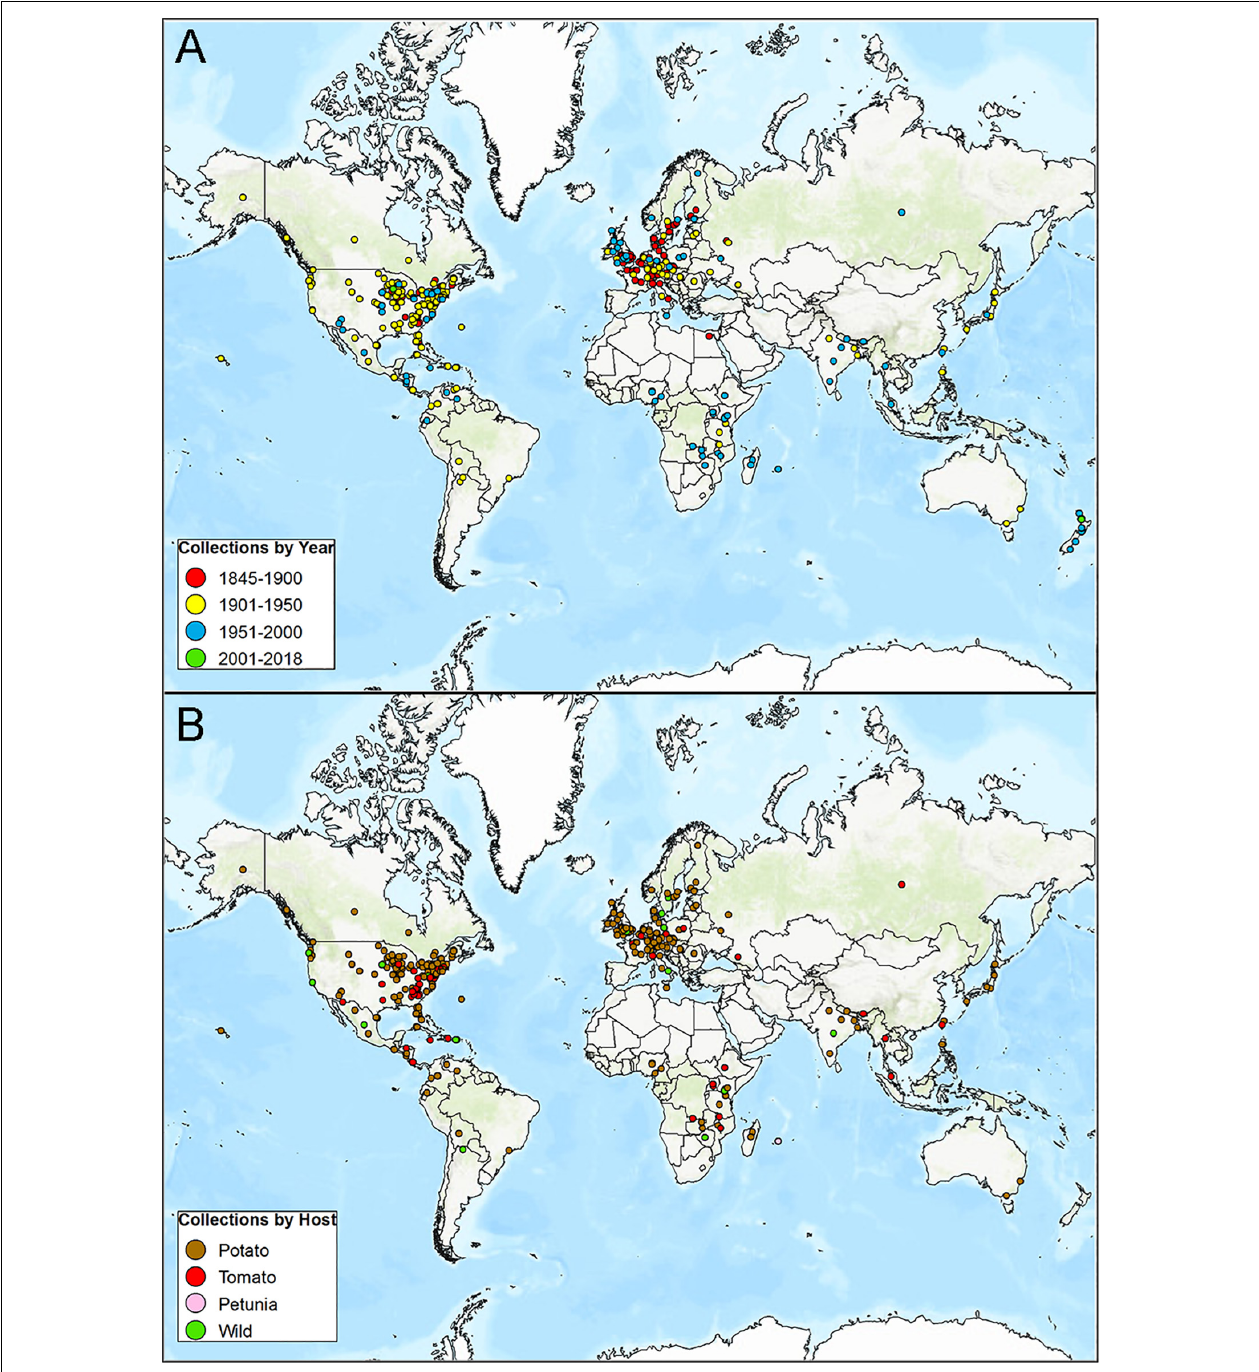
FIGURE 3 | Distribution of late blight caused by P. infestans herbarium records. (A) Sorted by year from 1845 to 2018. (B) Collections sorted by host including potato, tomato, wild Solanum species, or petunia. Herbarium records mined from a search of MyCoPortal.